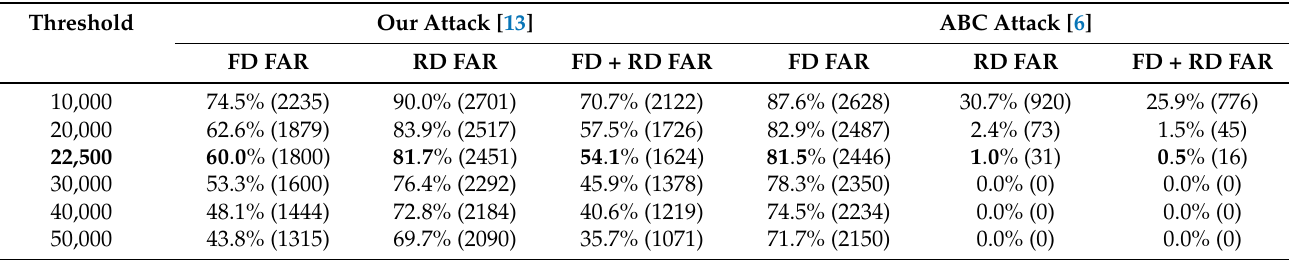
Table 1. False acceptance rates (FAR) and number of successful attempts (in parentheses) for the attack scheme proposed in [13] versus the attack scheme detailed in [6], when five images are used for PRNU estimation in the standard ABC protocol. False acceptance rates are computed for five PCE thresholds between 10,000 and 50,000. Results (highlighted in bold) for the optimal PCE threshold (22,500) are also included. For each attack scheme, we report the false acceptance rates for the Forgery Detection (FD) system, the Removal Detection (RD) system and both (FD +